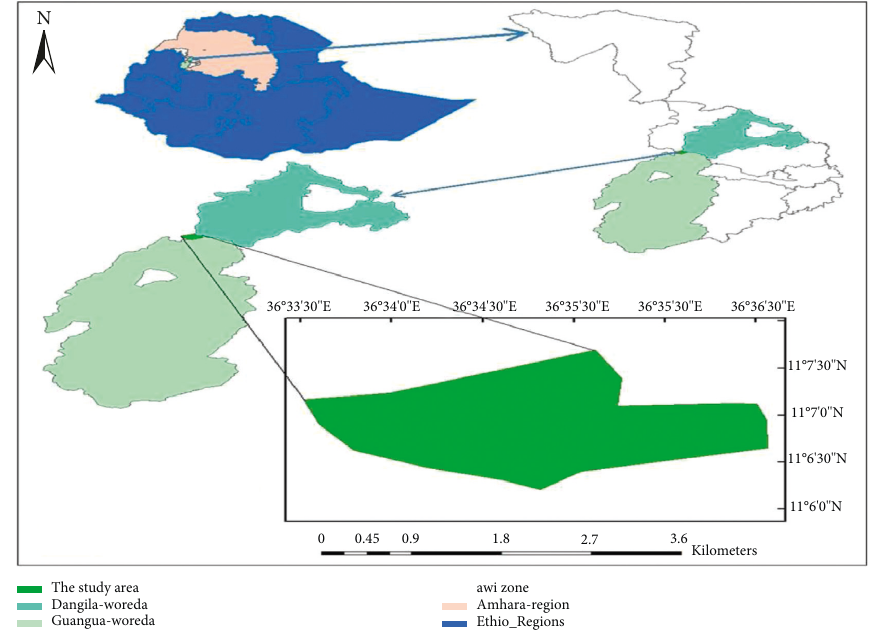
Figure 1: Map of the study